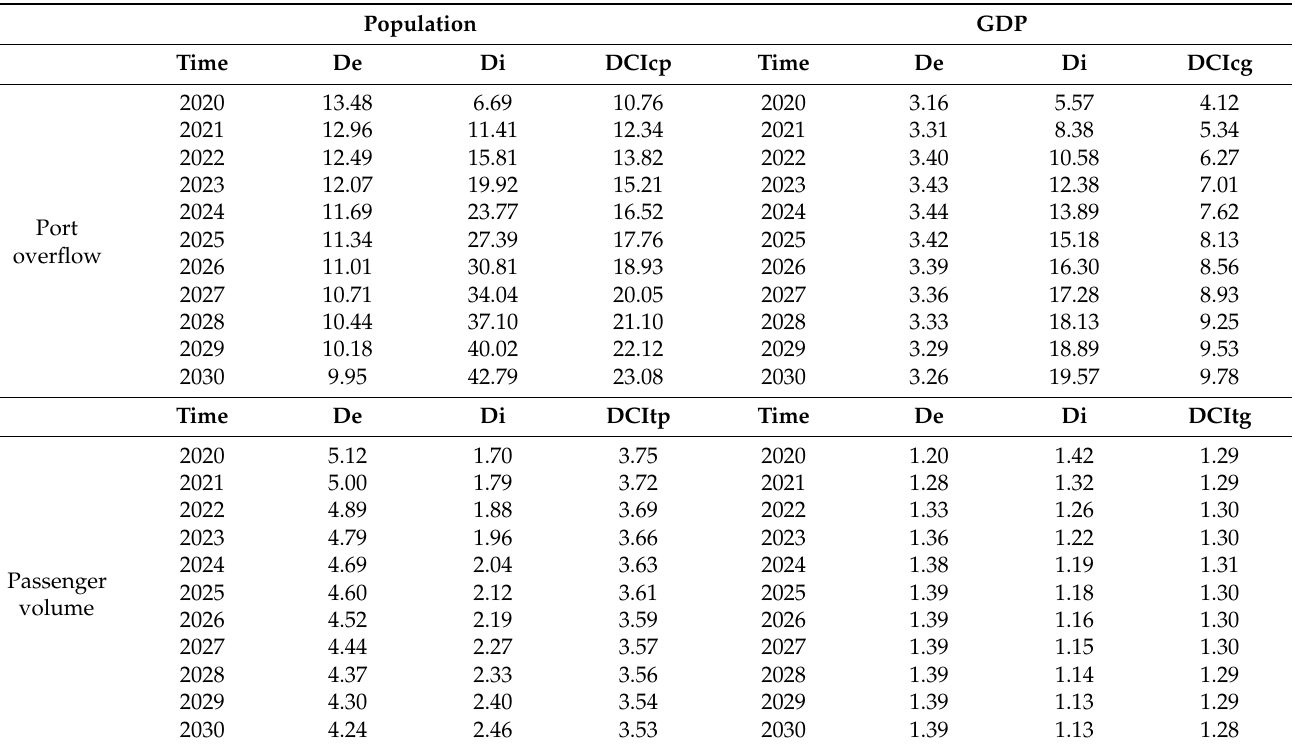
Table 6. Cross DCI values for each